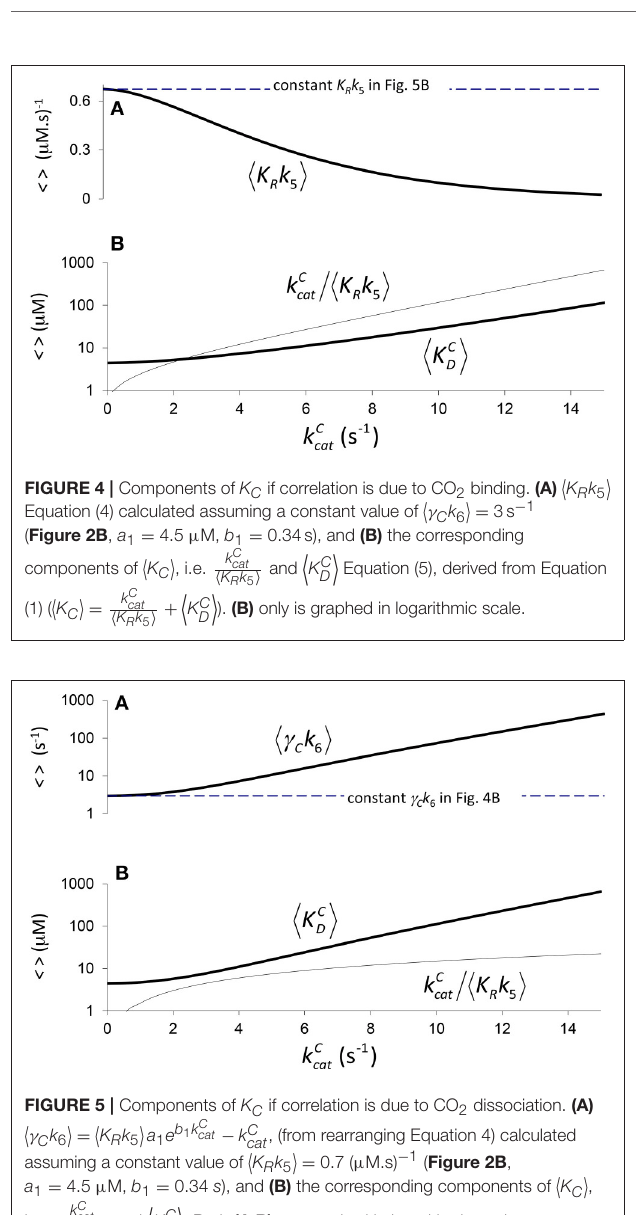
K C , (cid:10) (cid:11)